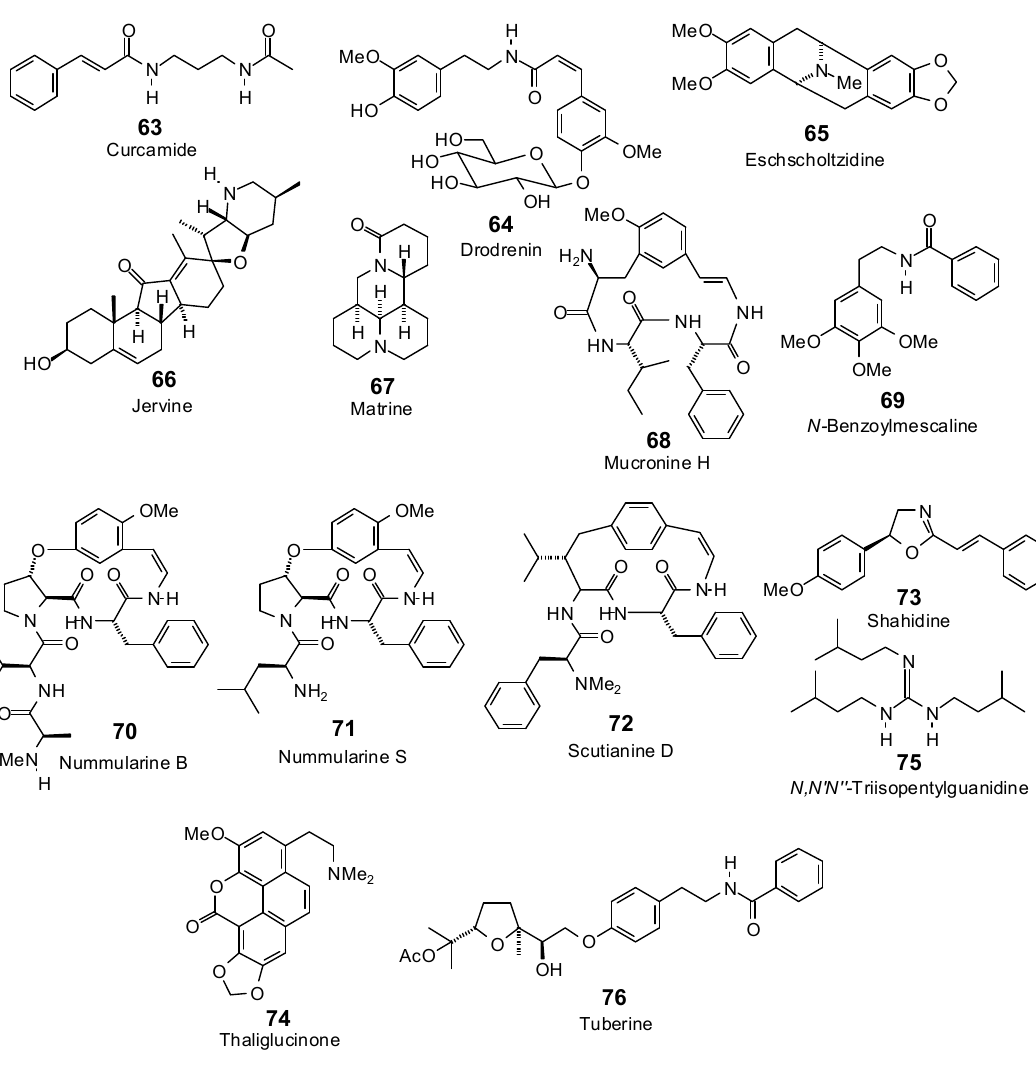
Figure 4. Miscellaneous alkaloids examined in this work.